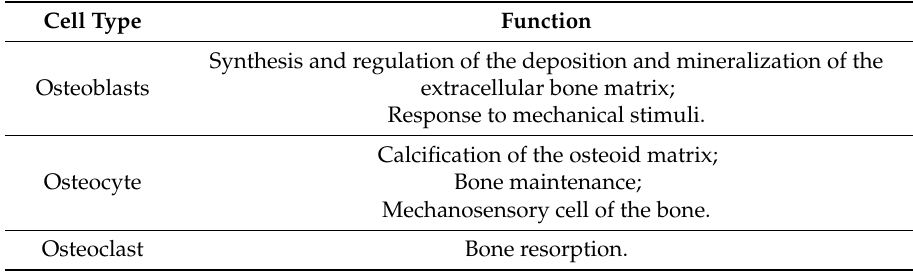
Table 2. Bone cells and their functions. Reproduced with permission from [26].